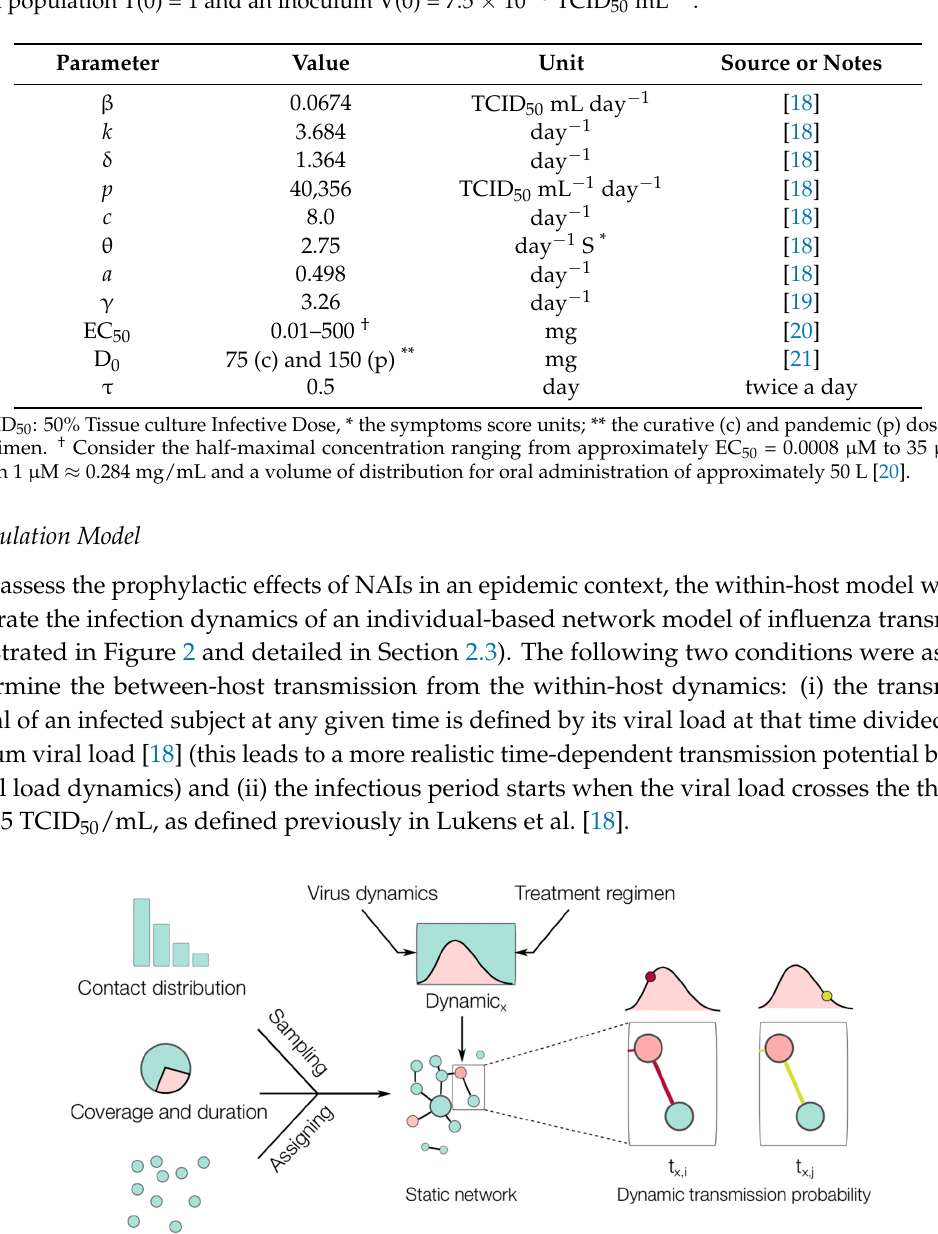
Table 1. Parameter values used in the simulations. The initial conditions corresponded to a susceptible